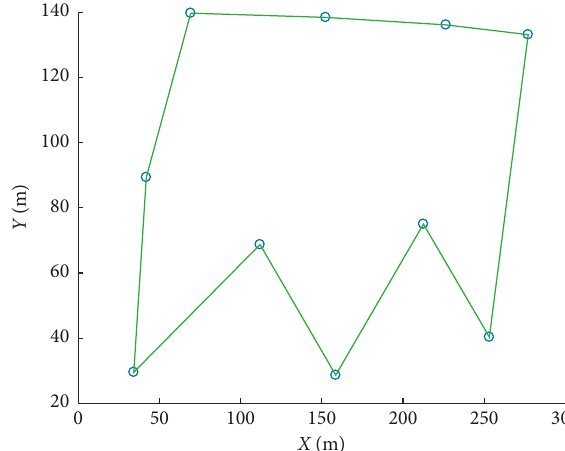
Figure 8: Path that does not initially consider wireless signal coverage.